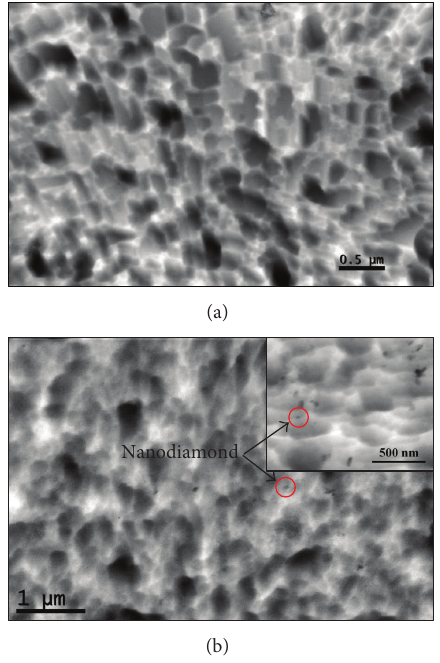
Figure 2: TEM images of films deposited by e-spray method: (a) P3HT:PCBM and (b) P3HT:PCBM doped with 1.5wt% nanodia-